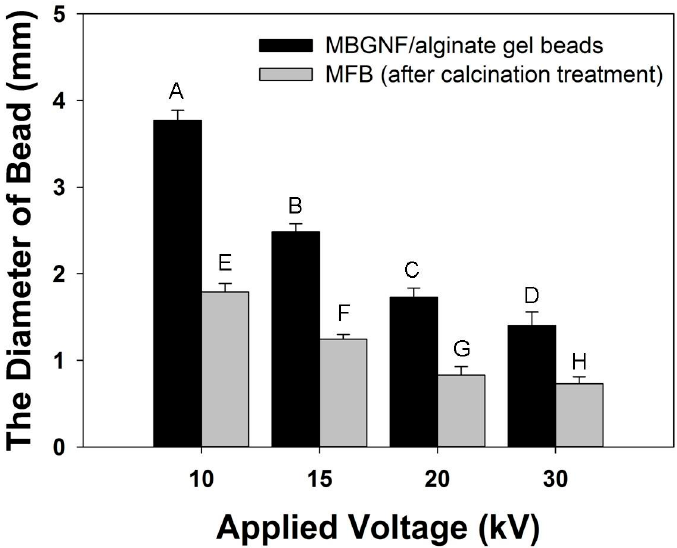
Figure 3. The diameter of MBGNF/alginate gel beads and MFBs as a function of the voltage magnitude. The data are presented as mean ± standard deviation, n = 50. The different letters represent significance at p < 0.05, as determined by the one-way ANOVA with Tukey’s post hoc test.